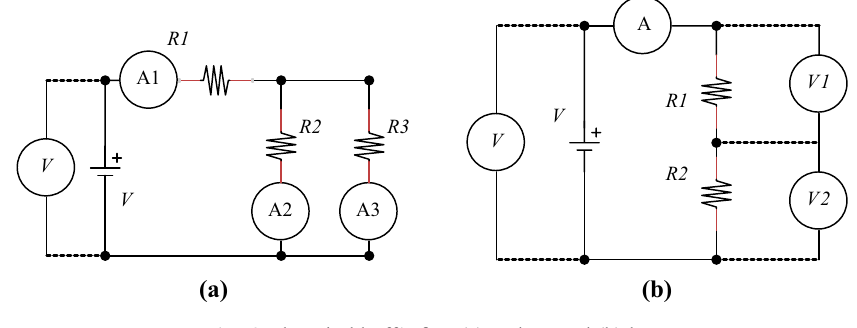
Fig. 6. The Kirchhoff’s first (a) and second (b) law